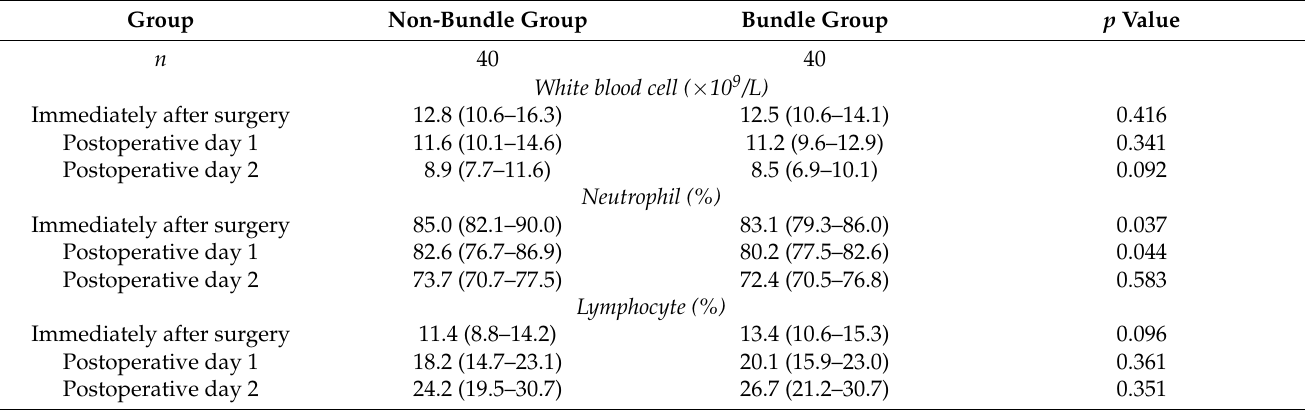
Table 4. Comparison of the postoperative inflammatory variables between the two